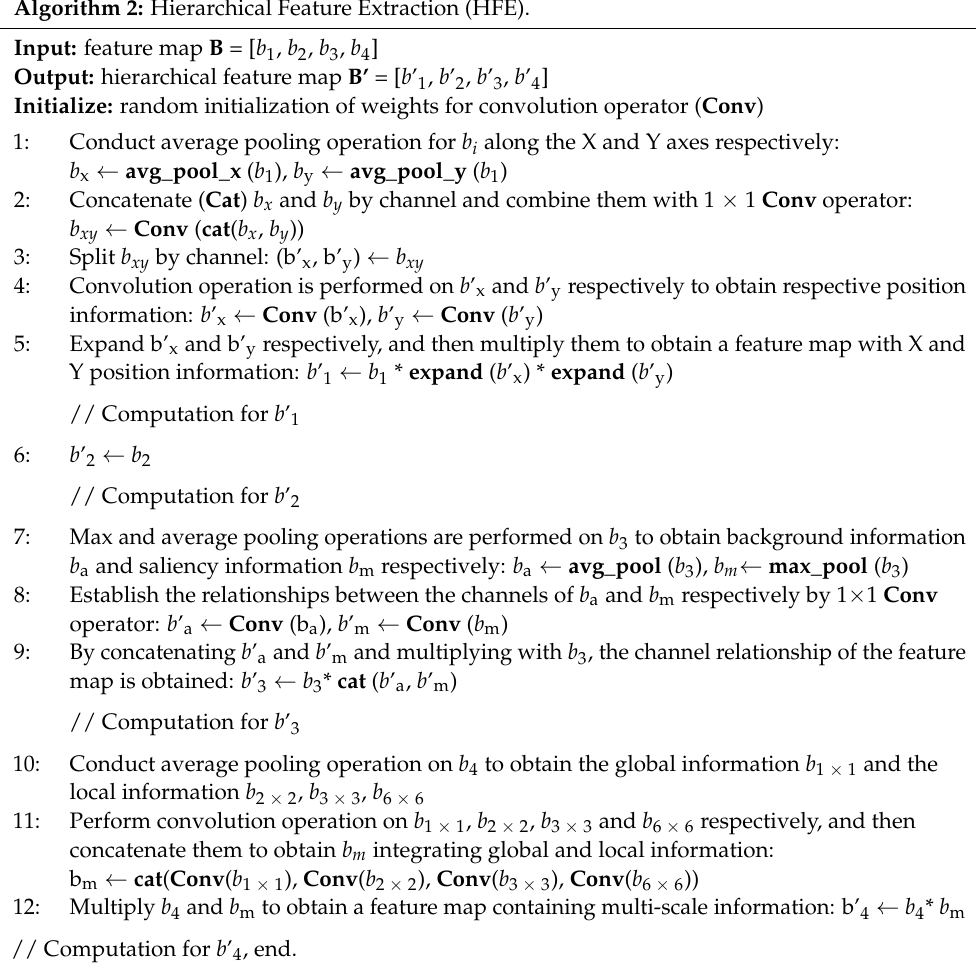
Algorithm 2: Hierarchical Feature Extraction